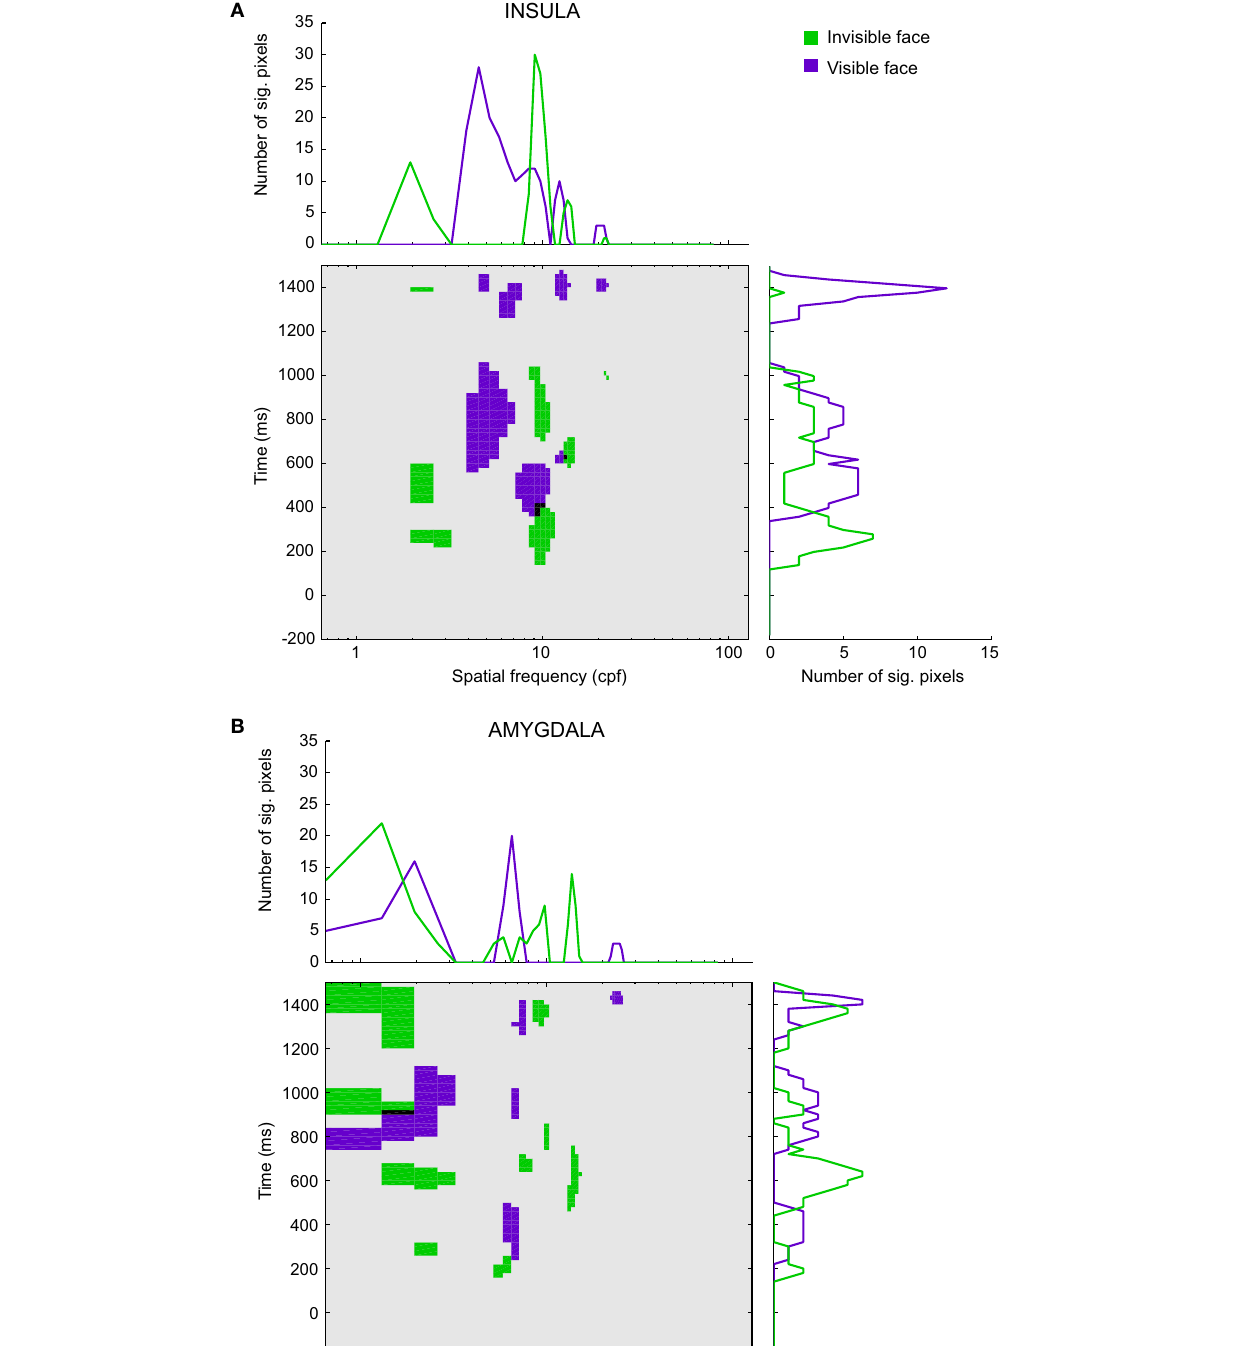
Number of sig. pixels